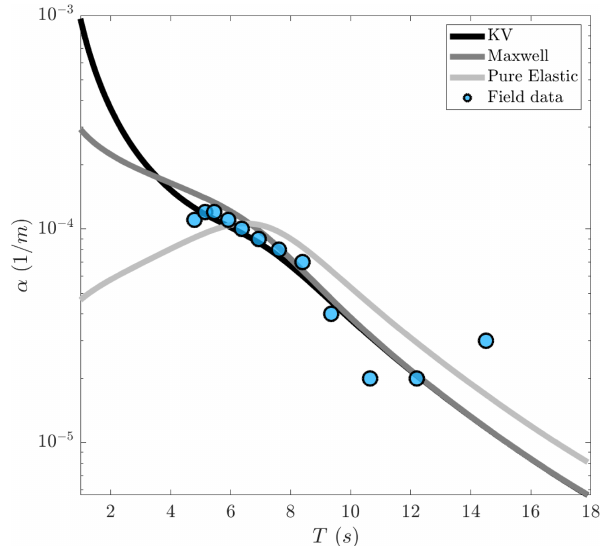
Figure A1. Comparison between α versus T curves constructed us- ing different wet beam models against those of field measurements documented in Wadhams et al. (1988). Curves are constructed using the inputs giving the best fitting, which can be seen in Legends and captions of Fig.